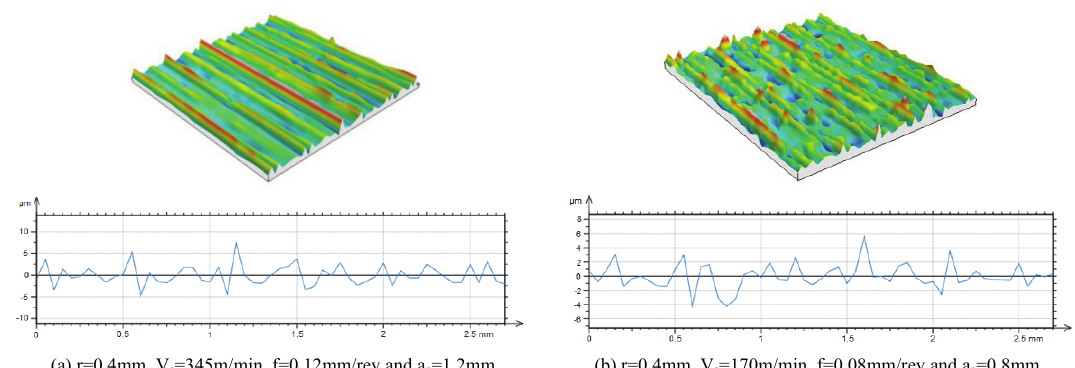
Fig. 18. Topographies of machined surfaces of turned AISI 12L14 free-cutting